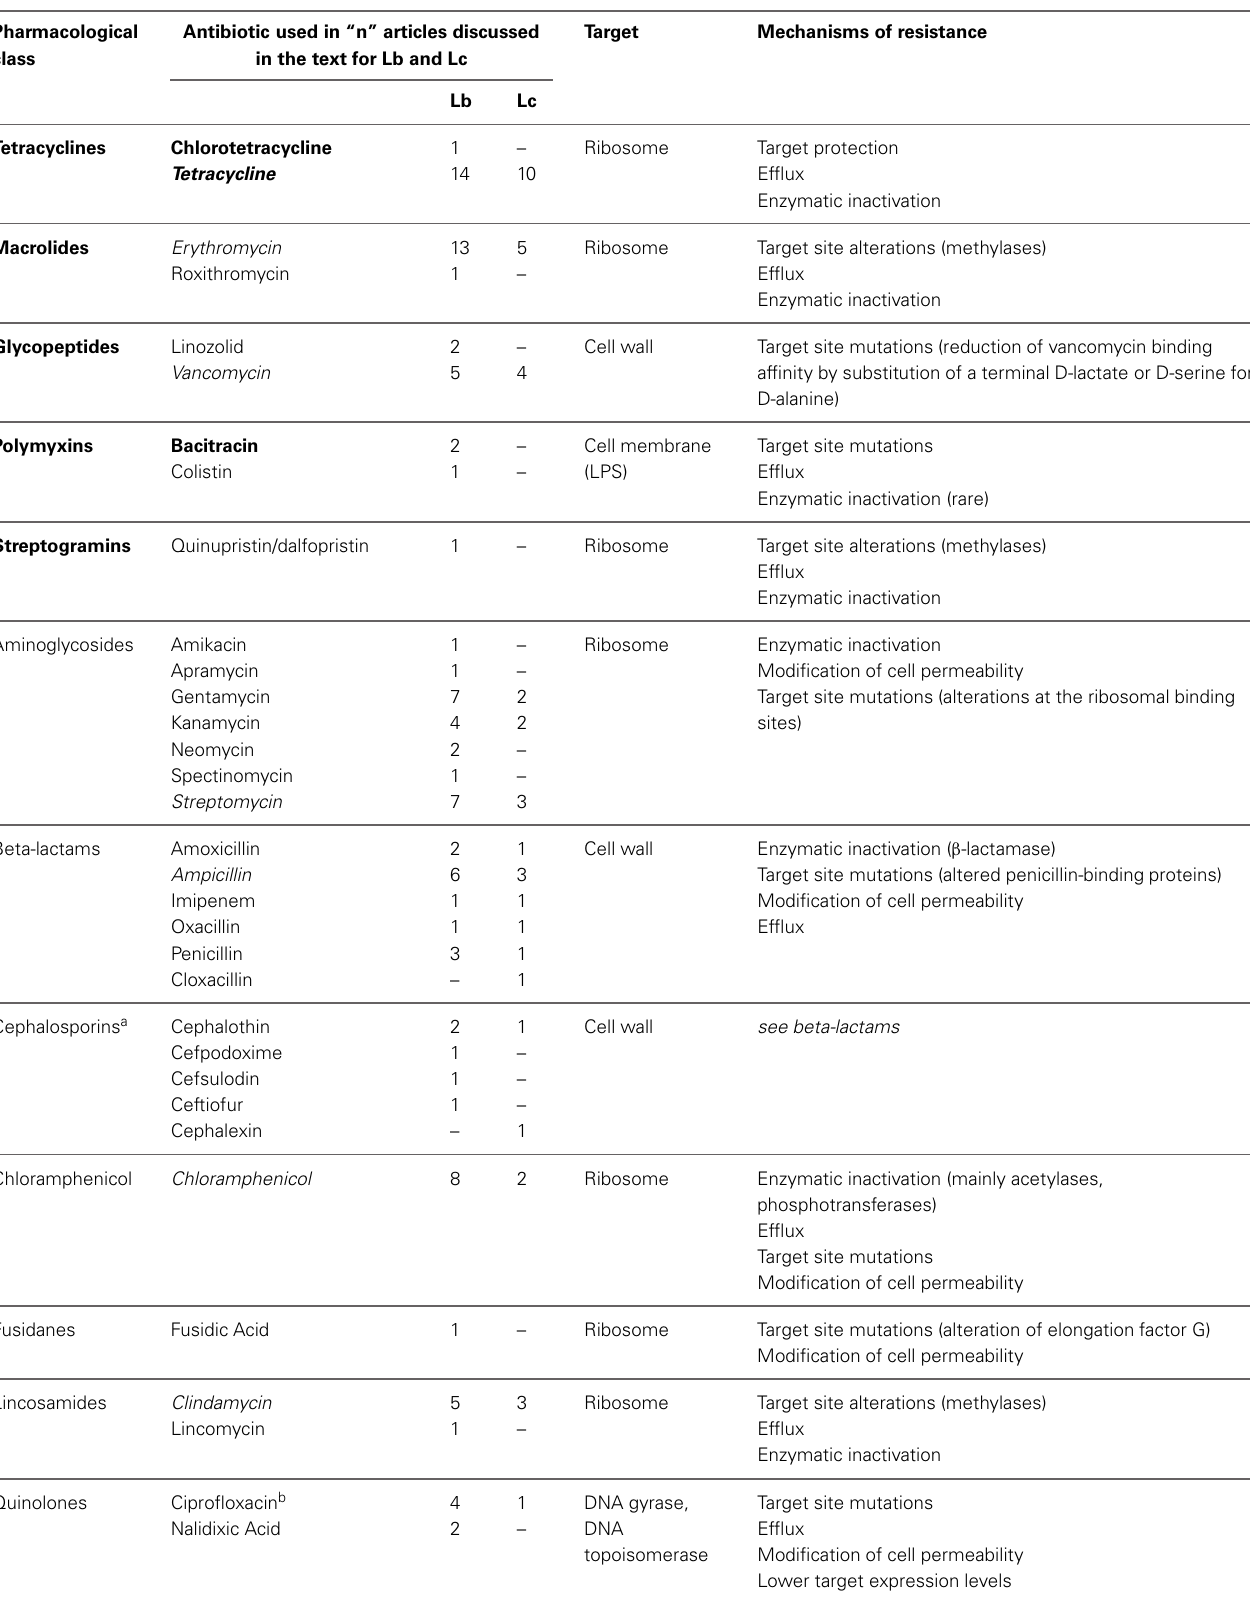
Table 1 | List of antibiotics used for the identification of foodborne ARLb and ARLc.